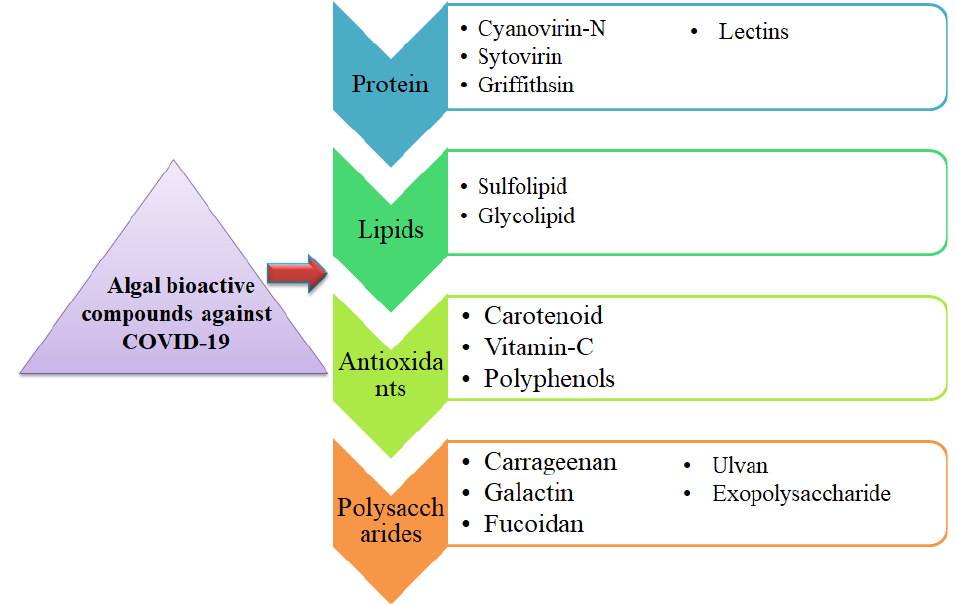
Figure 1. Bioactive metabolites extracted from algae and their possible approach to treating or preventing COVID-19.